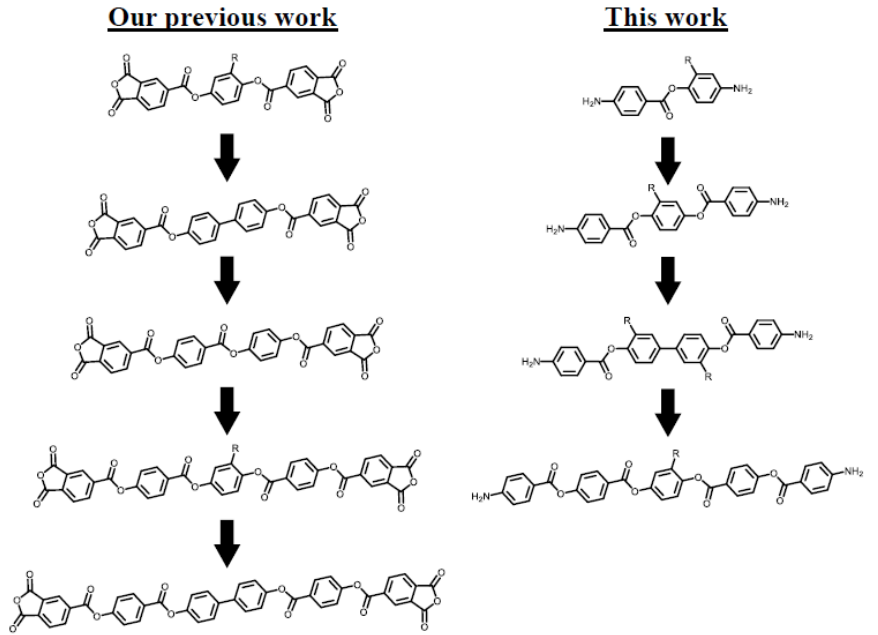
Figure 1. Our strategies for obtaining the next-generation of high-temperature dielectric substrate materials in FPCs by using ester-linked monomers with longitudinally extended structures.